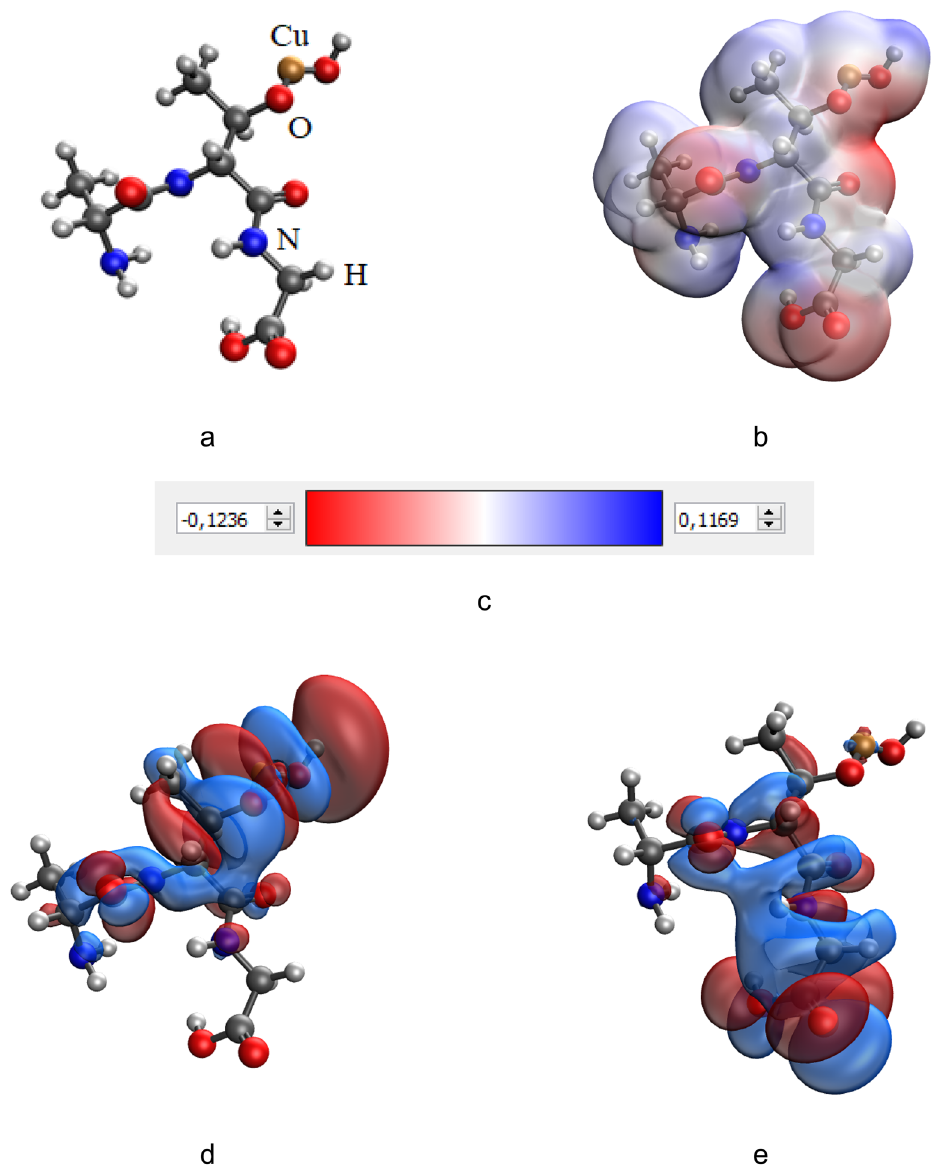
Figure 7. Results of the quantum-chemical simulation of the gelatin segment, bonded with CuO molecule (Ala-Thr-Gly-CuO): a model of the molecular complex ( a ), the distribution of electron density ( b ), electronic density distribution gradient ( c ), HOMO ( d ), LUMO ( e